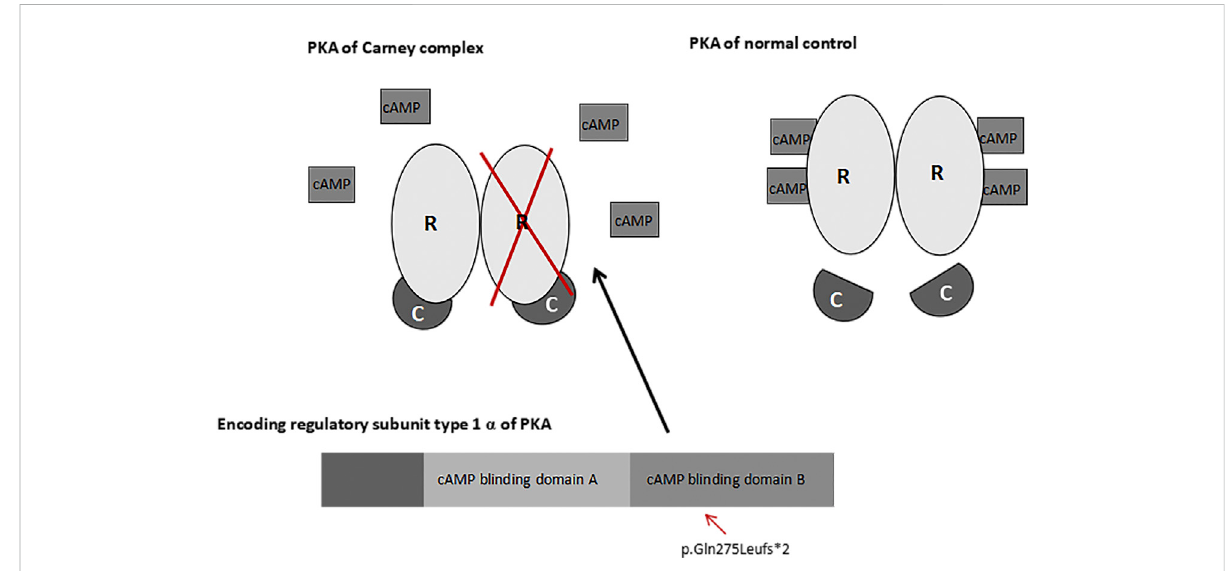
FIGURE 7 PRKAR1A and PKA pathways. A change in the coding protein inactivated the cAMP nucleotide binding domain B in PKA. As a result, Camp failed to bind with the regulatory subunit (R) or release the catalytic subunit (C) of